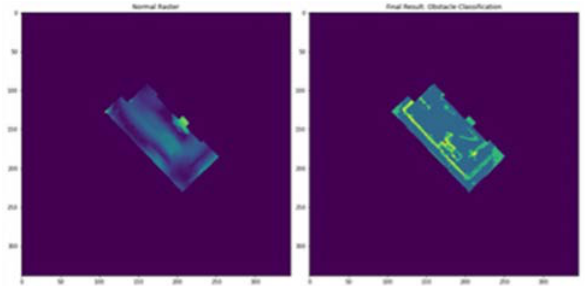
Figure 4 . Rasterization and overlay of the two first methods, yielding three obstacle probability classes: 0% (blue), 50% (green) and 100% (yellow)